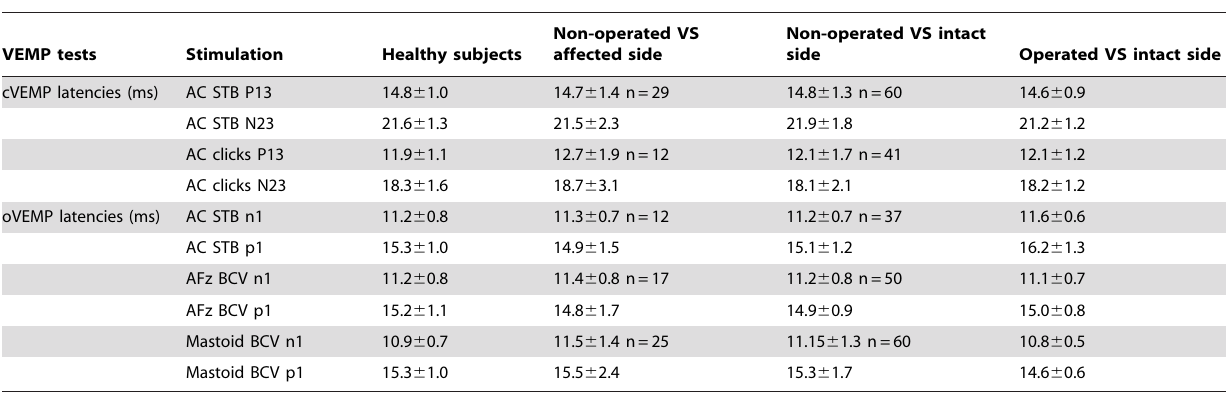
Table 2. Mean ( 6 SD) latencies of cVEMP induced by STB and clicks (P13 and N23) and of oVEMPs induced by AC STB and BCV (AFz and mastoid; n1 and p1), in healthy subjects, 63 patients with non-operated VS (affected and intact side) and 20 patients after surgery for VS (intact